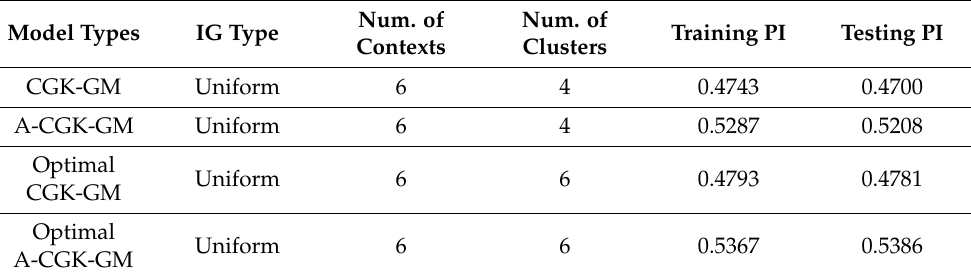
Figure 16. Performance index of the optimized CGK-based fuzzy granular model of the aggregated structure. Table 9. Result of the concrete compressive strength prediction experiment.